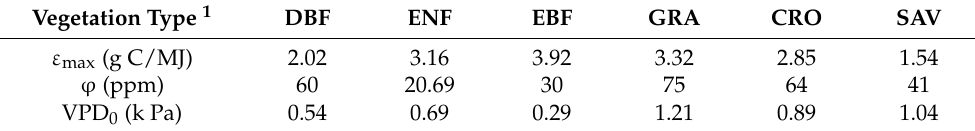
Table 2. Model parameters used in EC-LUE for different vegetation types [51]. Vegetation Type 1